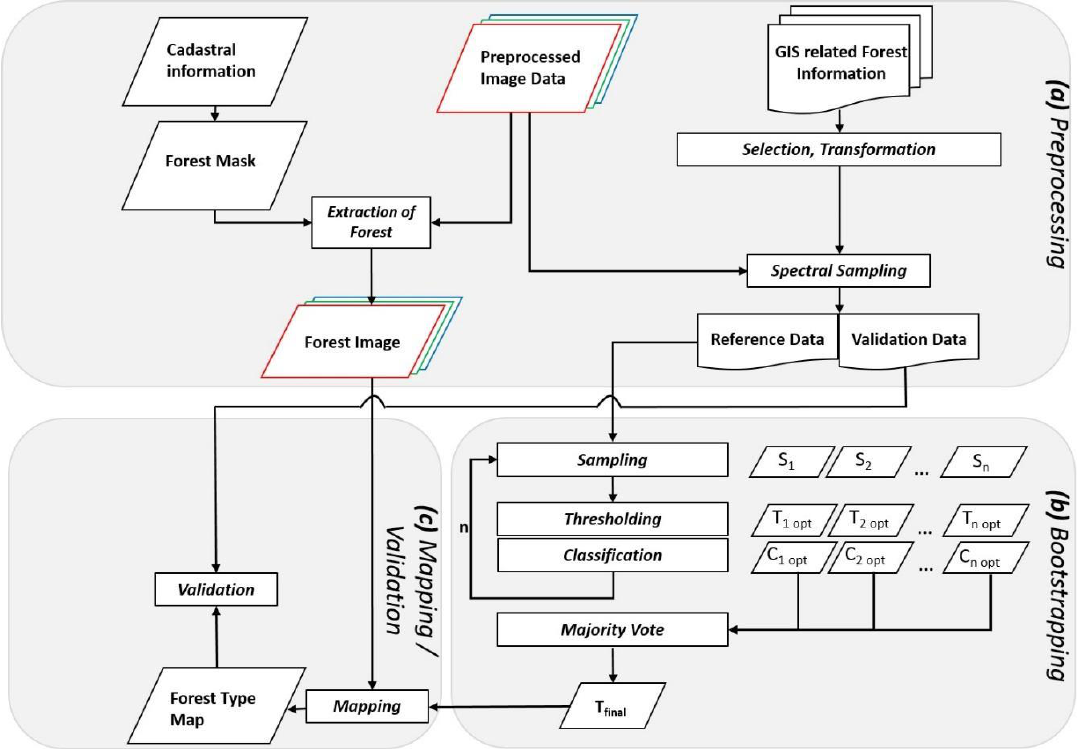
Figure 4. Processing flowchart including the pre-processing part ( a ), the parameterization part based on the bootstrapping method ( b ) and the mapping and validation part ( c ).